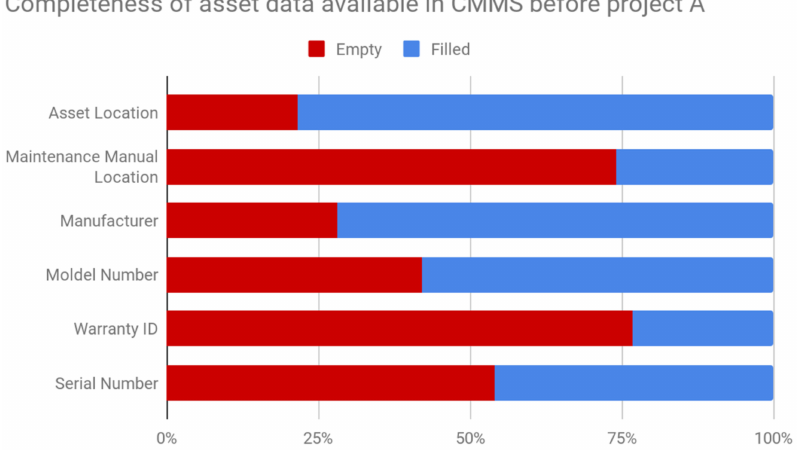
Figure 5. Percentage of missing fields of information for the existing facilities prior to project A. More than half of the verified assets did not have any information about maintenance manual location, warranty, or serial